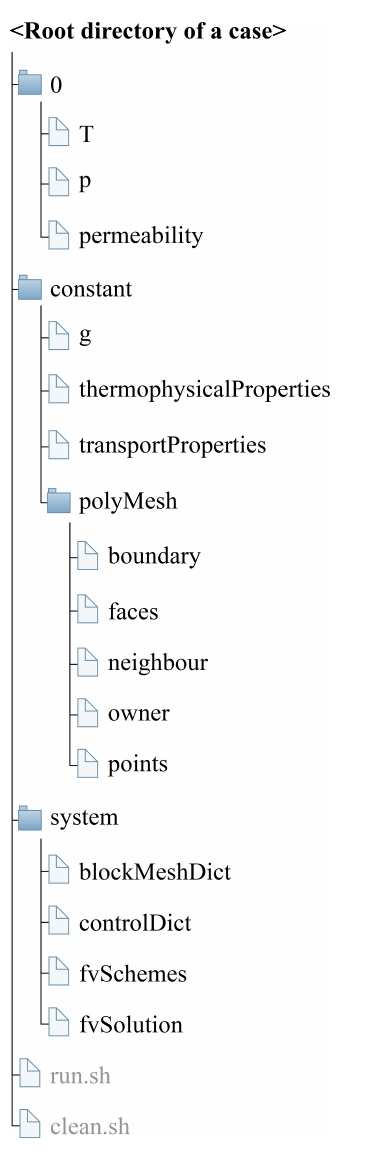
Figure 4. Case directory structure of the HydrothermalFoam tool- box.